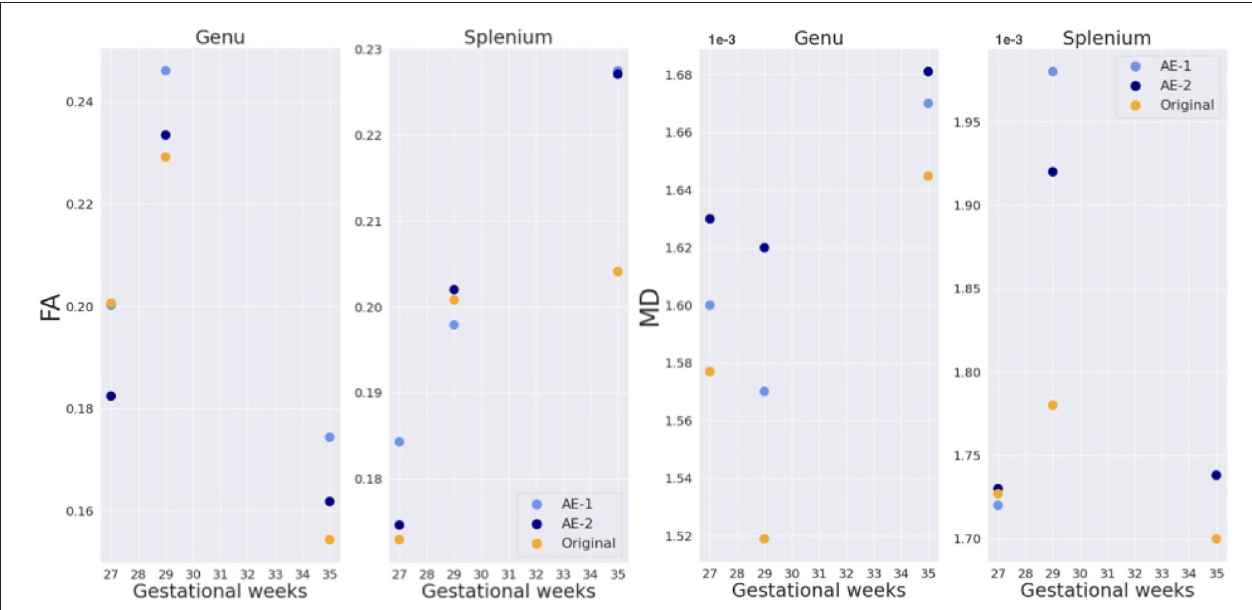
FIGURE 13 | FA and MD in genu and splenium of the corpus callosum for three subjects (sub-1, sub-2, and, sub-6 of, respectively, 27, 29, and 35 GW).